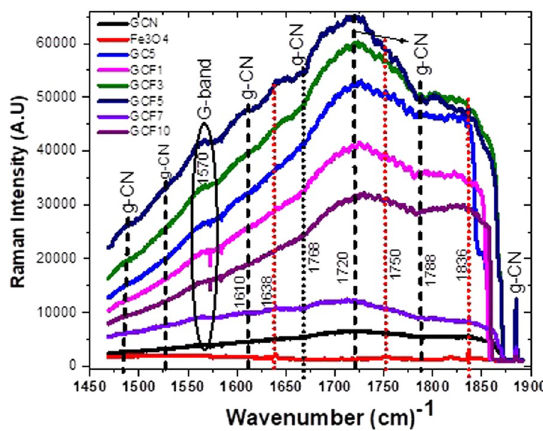
Figure 5. Resolved Raman Spectra of –gC 3 N 4 nanosheets composite